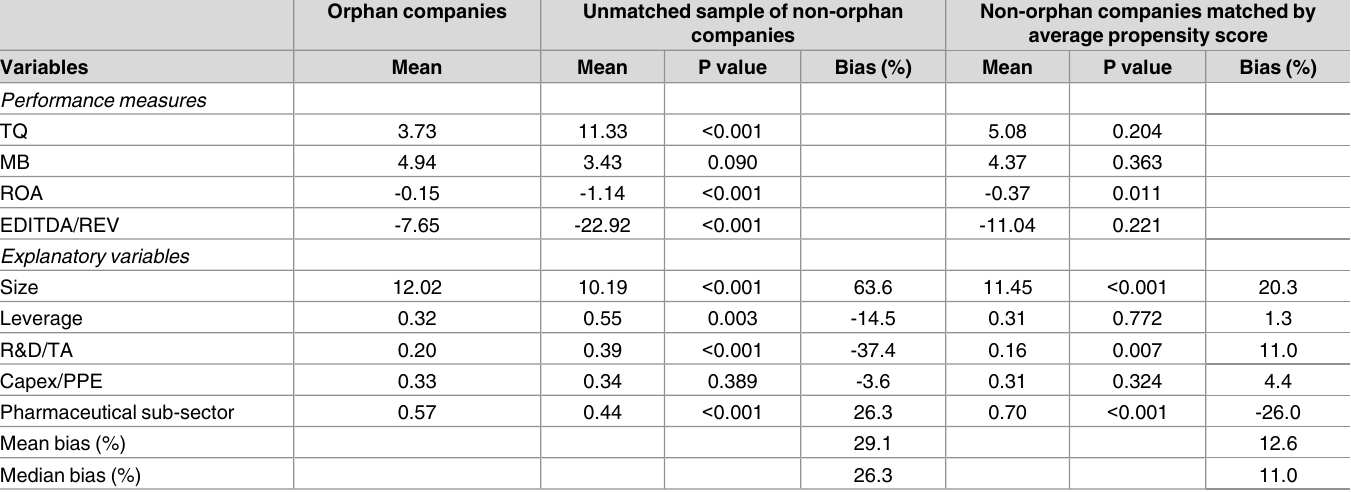
Table 3. Mean values of financial variables for orphan and non-orphan drug